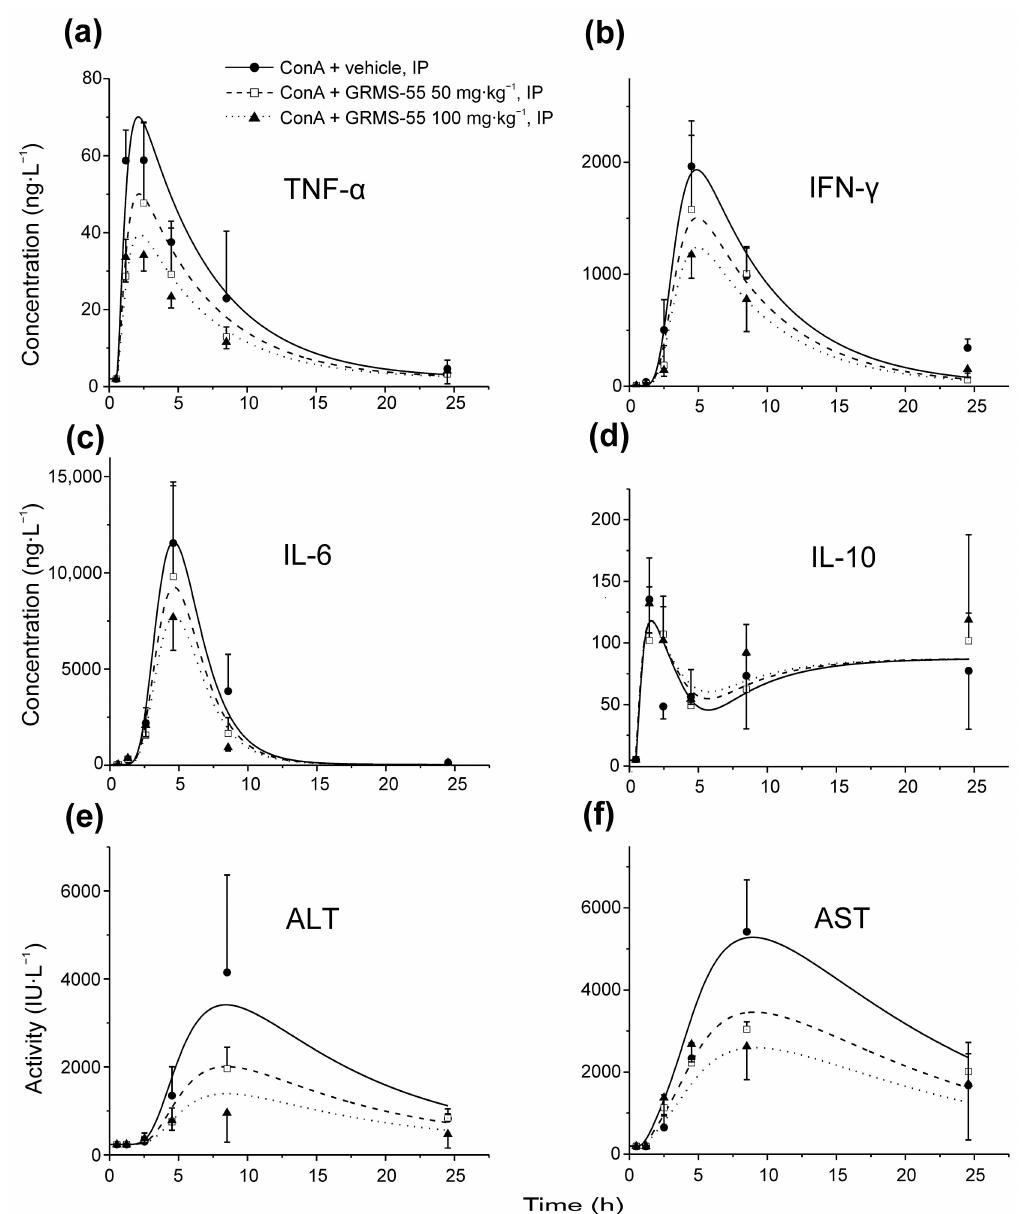
Figure 4. Mean ( ± SD) concentrations of ( a ) TNF- α , ( b ) IFN- γ , ( c ) IL-6, and ( d ) IL-10 and activities of ( e ) ALT and ( f ) AST in the serum of mice challenged with an IV dose of ConA in the absence or presence of GRMS-55 at doses of 50 or 100 mg · kg − 1 , IP ( n = 4–5). Observed quantities are shown as symbols, and PK/PD disease progression model predictions are shown as